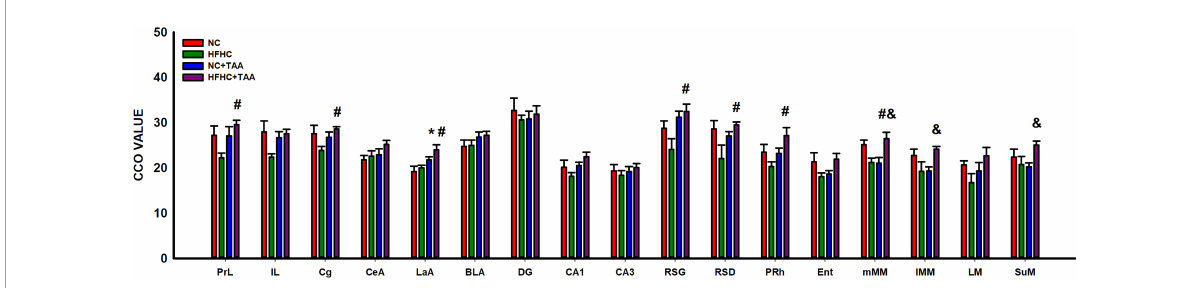
FIGURE13 Brain oxidative metabolism. Bars charts (mean ± SEM) represent CCO values. The studied regions were: the prefrontal cortex [prelimbic (PrL), infralimbic (IL), and cingulate (Cg) cortices], the amygdala [central (CeA), lateral (LaA), and basolateral (BLA)], the dorsal hippocampus [dentate gyrus (DG), CA1 and CA3 areas, the retrosplenial (granular (RSG), and dysgranular (RSD)], the perirhinal (PRh) and entorhinal (Ent) cortices and the mammillary bodies [medial nucleus (mMM), the lateral part of the medial nucleus (lMM), the lateral mammillary nucleus (LM), and the supramammillary nucleus (SuM)]. These values were compared through a one-way ANOVA followed by Tukey’s test (*comparison with NC, # comparison with HFHC, & comparison with NC + TAA; * #& p < 0.05).